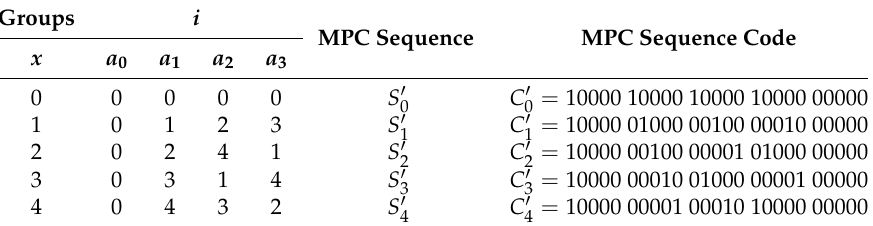
constructed for p = 5 and w = 4. i